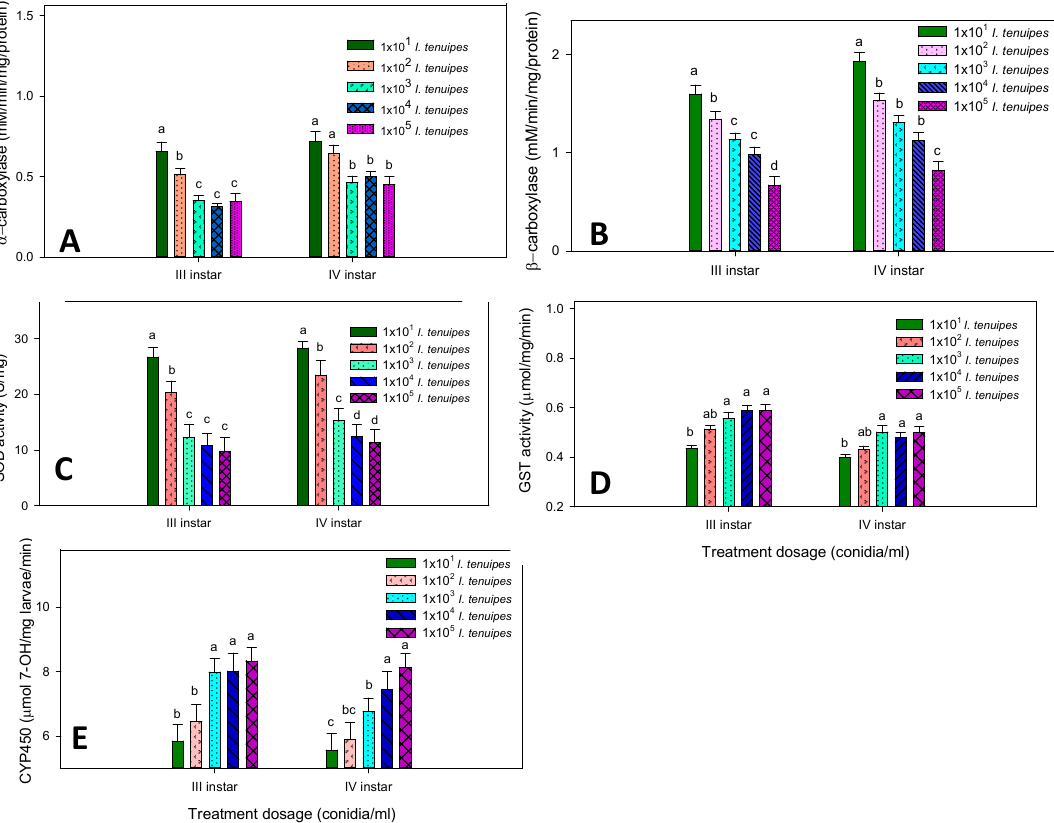
Figure 5. ( A ) α-carboxylestrase; ( B ) β-carboxylestrase; ( C ) SOD; ( D) GST; ( E ) CYP450 enzyme activity of third and fourth instar larvae of Ae. aegypti after treatment with My-It. The data were fitted on a polynomial (regression) model. Letters (a-d) mean (± SE) followed by the same letters above bars indicated no significant difference ( p ≤ 0.05) using ANOVA analysis.